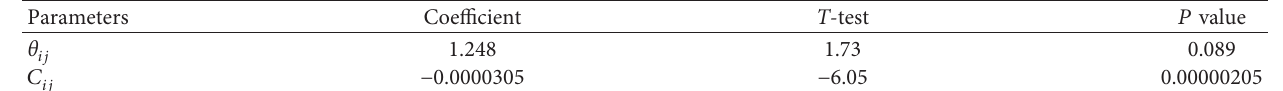
Table 4: MNL based on travel cost ( R 2 � 0 . 4607 ) .